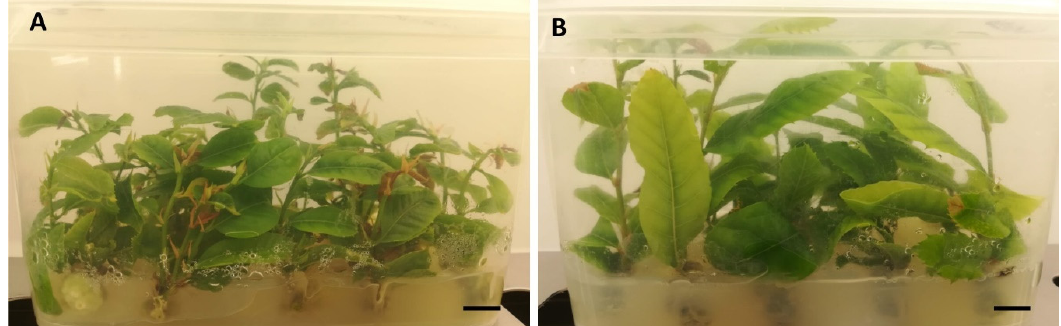
Figure 2. SM904 shoots after 6 weeks in ( A ) MSB and ( B ) WPMZ media. Bar = 1 cm.